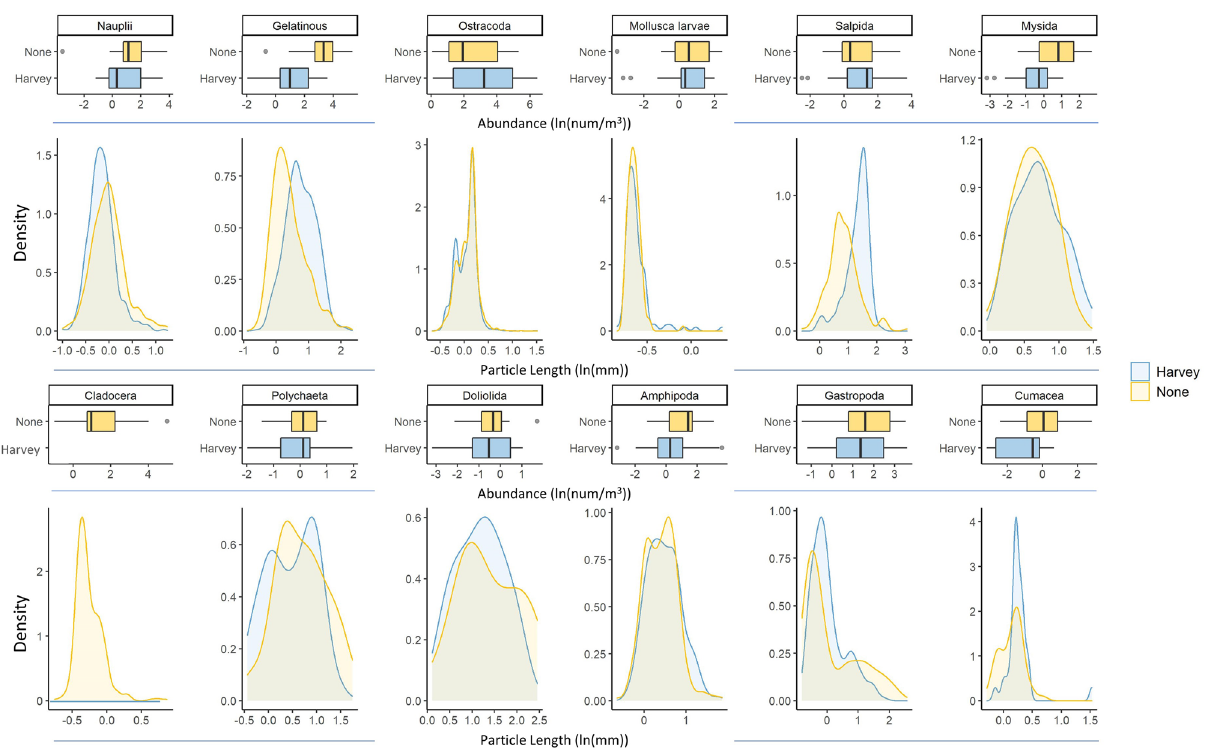
Figure 2. Standardized abundance (num. indv./m 3 ) and maximum particle length distributions (mm) displayed for the 12 taxa determined to explain 57% of the dissimilarity between Harvey (blue) and non-storm (yellow) years (SIMPER analysis). Note that axis scales are not uniform to allow intra-taxa comparisons over Harvey and non-storm